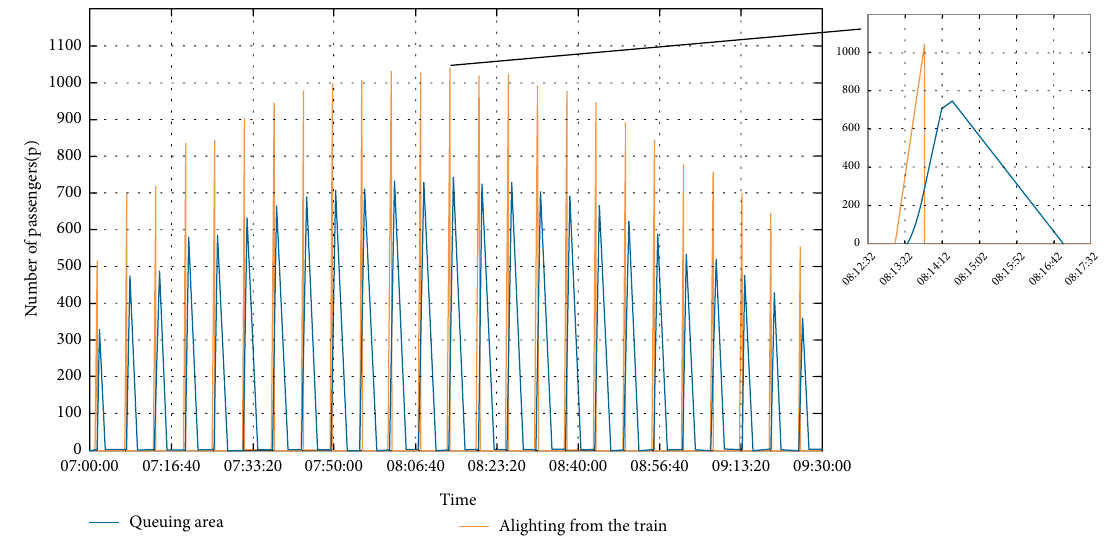
Figure 15: The number of passengers queuing at the exit of P_CPL over the whole simulation